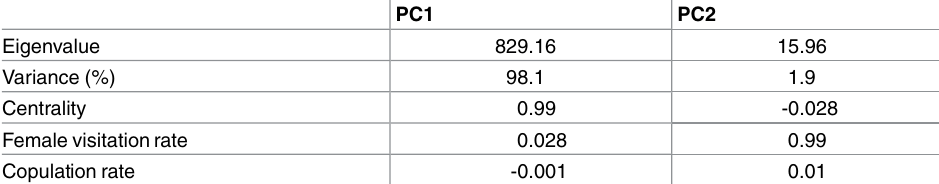
Table 2. The Principal ComponentAnalysisresults. Forty-one M . manacus males at 10 leks were used in